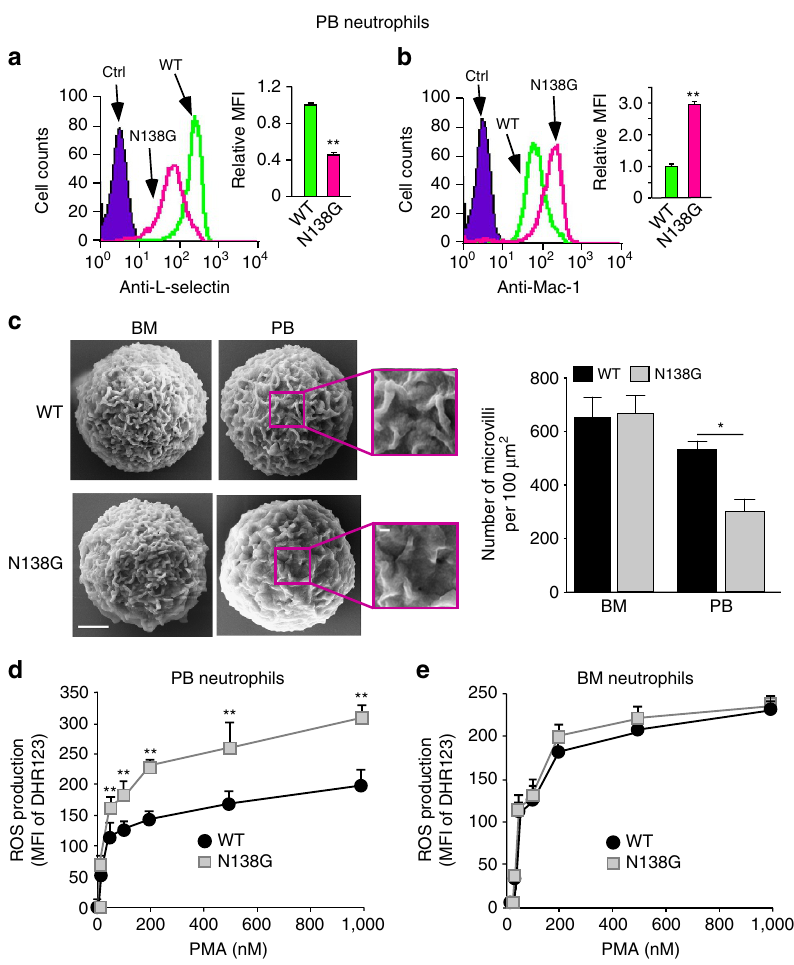
Figure 3 | Circulating neutrophils in N138G mice are primed. ( a , b ) Surface expression of L-selectin and Mac-1 on peripheral blood (PB) neutrophils of WT and N138G mice. Representative histograms and relative mean fluorescence intensity (MFI) in bar graphs are shown. The gating strategy for PB neutrophils is shown in Supplementary Fig. 9. Data are mean ± s.e.m. of five mice per group. ( c ) Scanning electron microscopy of neutrophils isolated from PB or BM of WTand N138G mice (Bar, 1 m m). The boxed areas are magnified in the insets. Quantification of cell-surface microvilli in bar graph. Data are mean ± s.e.m. of 15–20 neutrophils from five mice per genotype. ( d , e ) Reactive-oxygen species (ROS) generated by PB or BM neutrophils in response to phorbol myristate acetate (PMA). Data are mean ± s.e.m. from six mice per group in three experiments. * P o 0.05; ** P o 0.01 (two-tailed Student’s t